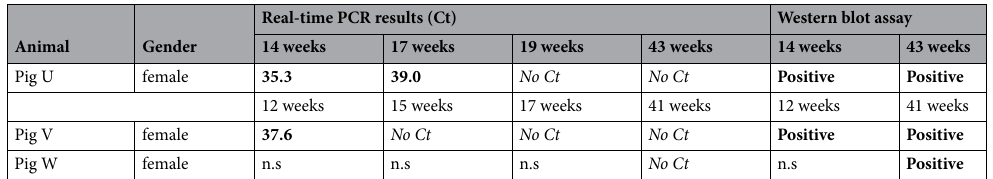
Table 2. Results of the real-time PCR testing of blood and the Western blot analysis or three pigs at four different time points corresponding to the age of the animals. n.s.—no sample available. PCR polymerase chain reaction, Ct cycle threshold. Positive values are in bold and negative values (no ct) in